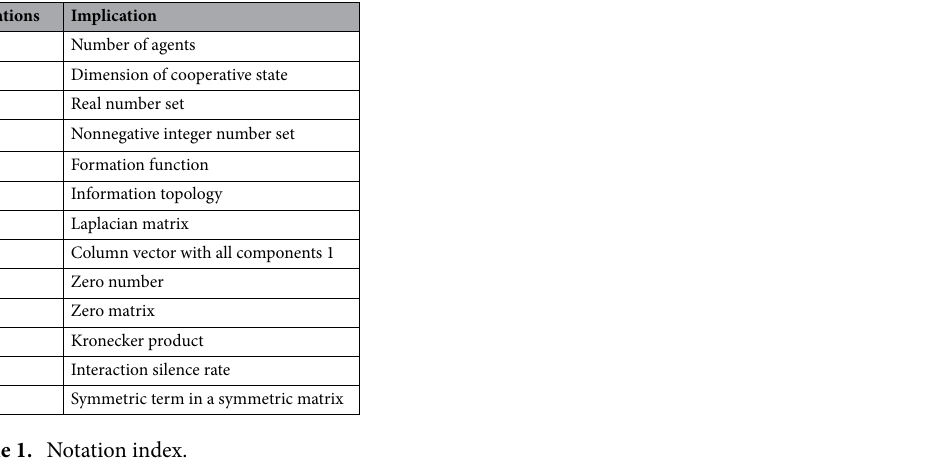
Table 1. Notation